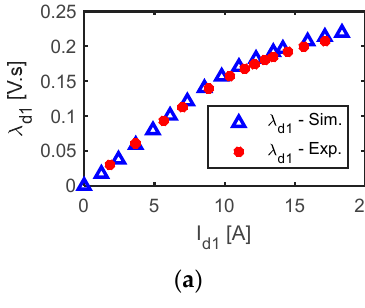
Figure 13. Simulated and measured ( a ) (cid:2019) (cid:2914)(cid:2869) ((cid:1861) (cid:2914)(cid:2869) , 0) and ( b ) (cid:2019) (cid:2927)(cid:2869) (cid:3435)0,(cid:1861) (cid:2927)(cid:2869) (cid:3439) at different currents and at standstill.